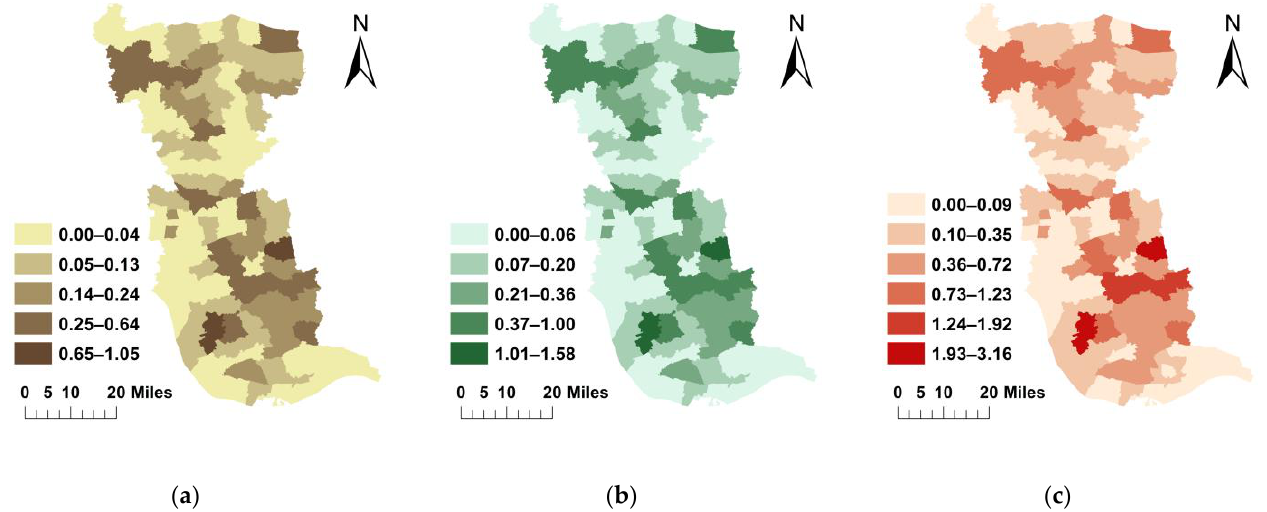
Figure 5. Land carrying capacity calculated with different ratios of livestock manure nutrients to total nutrients of agricultural fertilizers: ( a ) 30%, ( b ) 20%, and ( c ) 10%.